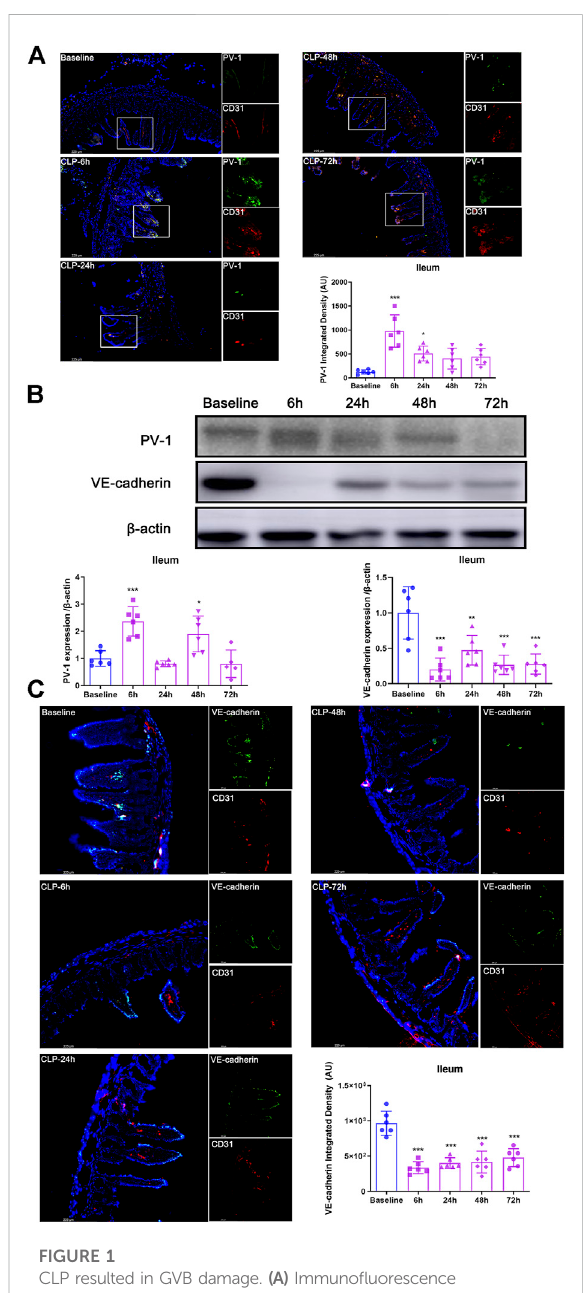
FIGURE 1 CLP resulted in GVB damage. (A) Immuno fl uorescence bimolecularCD31(red,amarkerofendothelialcell)andPV-1(green)in the ileum (×100). Nuclei were counterstained with DAPI (blue). Scale bars: 225 μ m. Quantitative analysis: integrated fl uorescence densityofPV-1, n =6. (B) ExpressionofPV-1andVE-cadherininileum after CLP operation by using western blot analysis, n = 6. (C) Immuno fl uorescence: CD31 (red), VE-cadherin (green) and DAPI (blue), ×200. Quantitative analysis: integrated fl uorescence density of VE-cadherin, n = 6. Data were expressed by mean ± SD. * p < 0.05, ** p < 0.01, *** p < 0.001 vs. Baseline